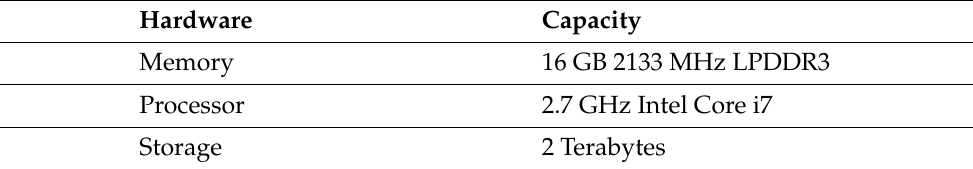
Table 1. Hardware